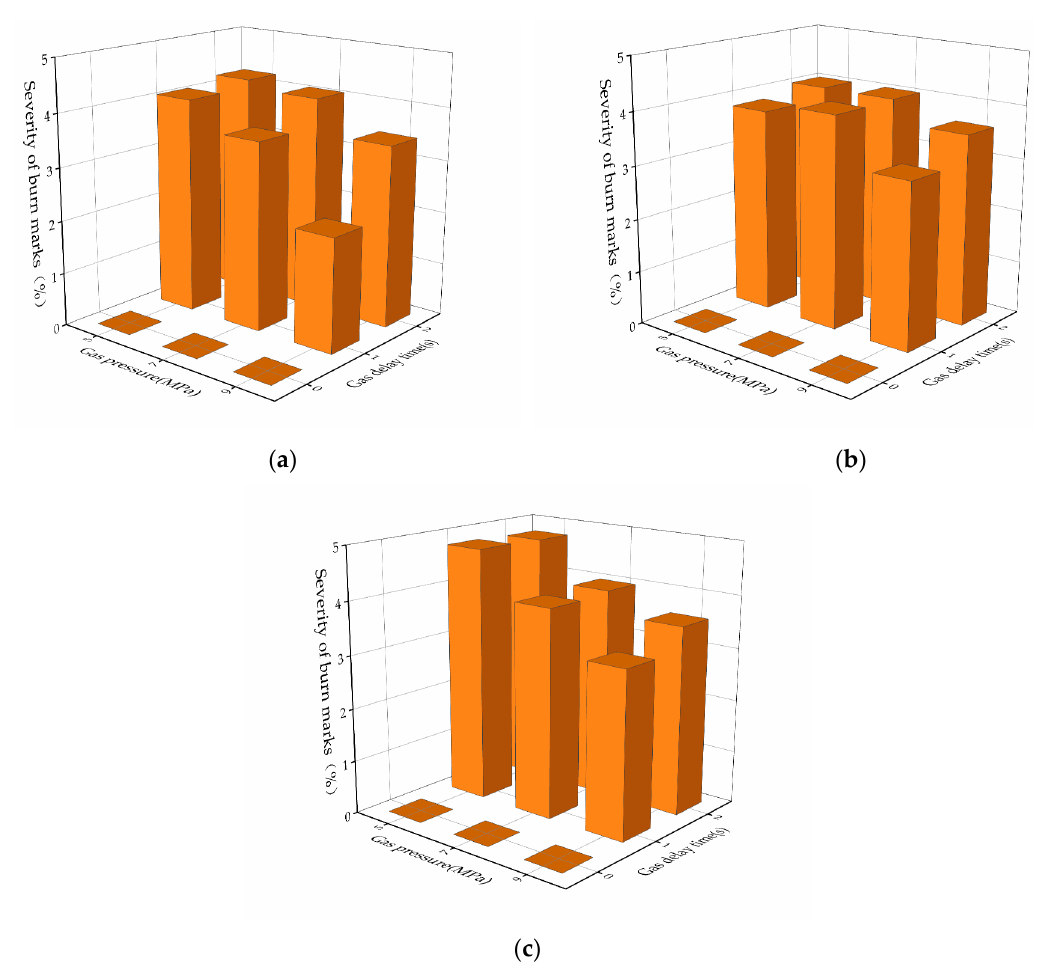
Figure 6. Influence of gas pressure and gas delay time on burn marks: ( a ) gas packing time of 10 s; ( b ) gas packing time of 20 s; ( c ) gas packing time of 30 s.